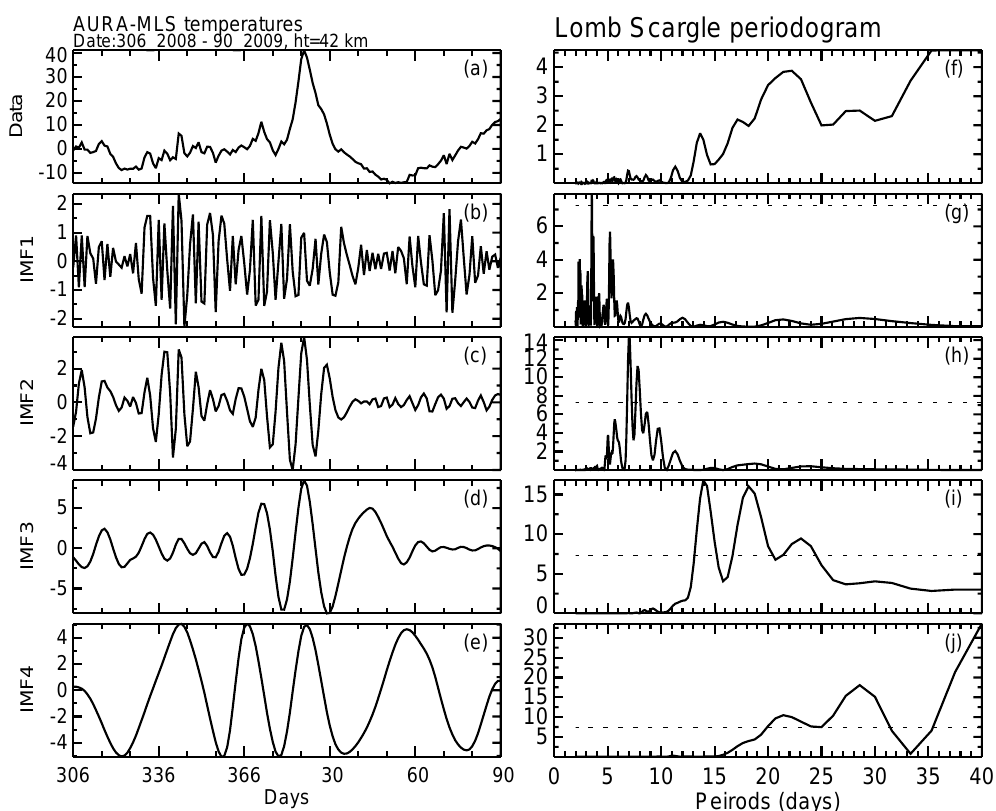
Fig. 4. Time series of (a) daily mean temperature anomalies observed using MLS during November 2008 to March 2009 at 42km altitude level. Intrinsic mode function components from the first to fourth IMFs are shown in (b) to (e) . Corresponding L-S periodograms are shown in (f) to (j) , respectively. Dashed horizontal line in (g) to (j) indicates 95% confidence level. Table 1. Planetary wave periods observed four different heights (32, 42, 52 and 62km) using MLS temperature and MERRA reanalysis zonal winds over the latitude range of 60–80 ◦ N during 2009 stratospheric warming